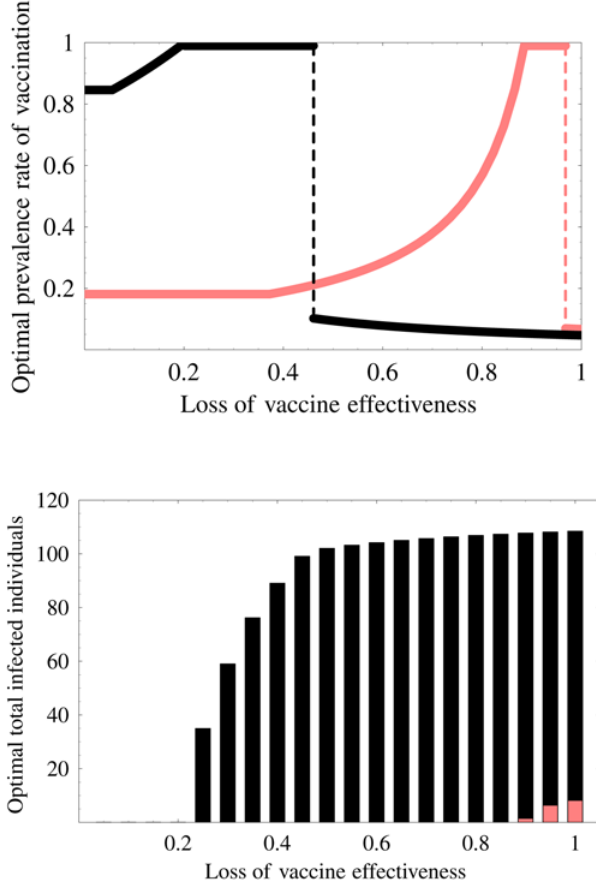
Figure 6. Effects of non-pharmaceutical intervention: The top figure shows the optimal prevalence rate of the vaccination program with (pink curve) or without (black curve) non- pharmaceutical intervention. The non-pharmaceutical intervention readily achieves the optimal prevalence rate and hinders the catastrophic change. The bottom figure shows the optimal final size of the epidemic with (pink bar) or without (black bar) the non- pharmaceutical intervention. The intervention also dramatically reduces the final size of the epidemic.